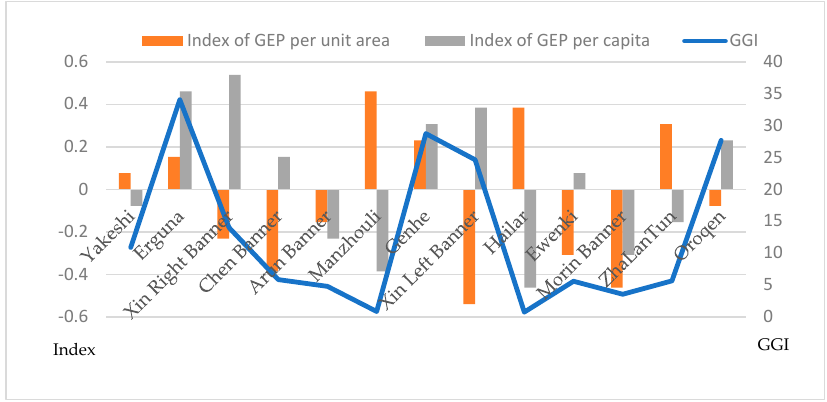
Figure 4. The index of GEP per unit area, index of GEP per capita, and GGI of each region in 2020.